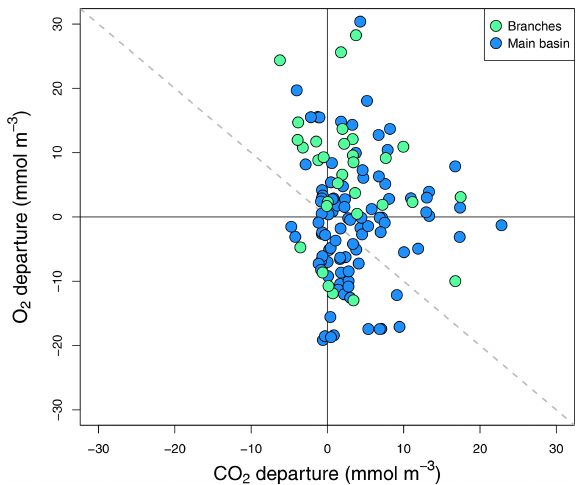
Figure 5. Surface O 2 vs. CO 2 departure from saturation for all sam- pled surface sites in the reservoir main basin and branches across all sampling campaigns.